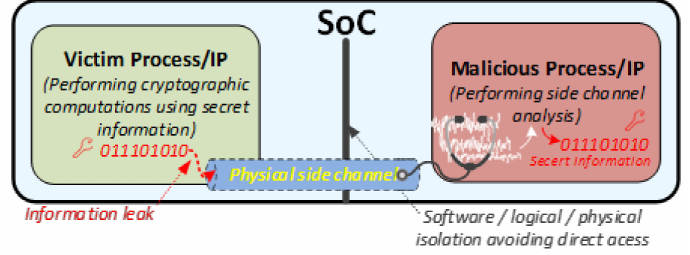
Figure 1. Conceptual view of an inside-SoC side-channel analysis.